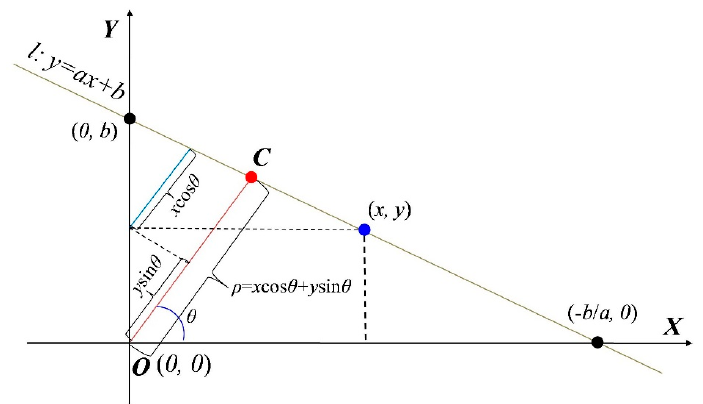
Figure 7. Schematic diagram of the Hough Transform used for line detection.